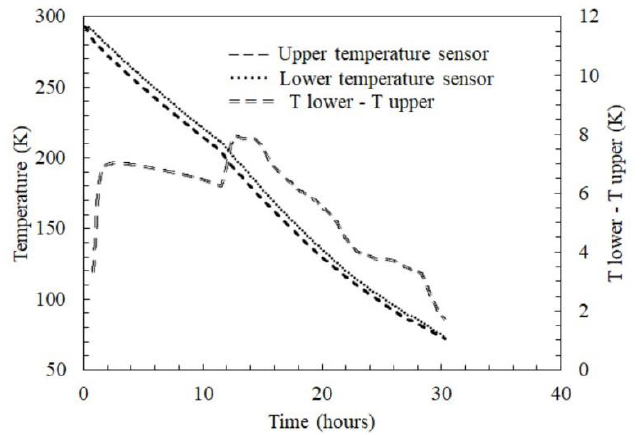
Figure 5. Temperature readings during cooling down and the difference between sensors